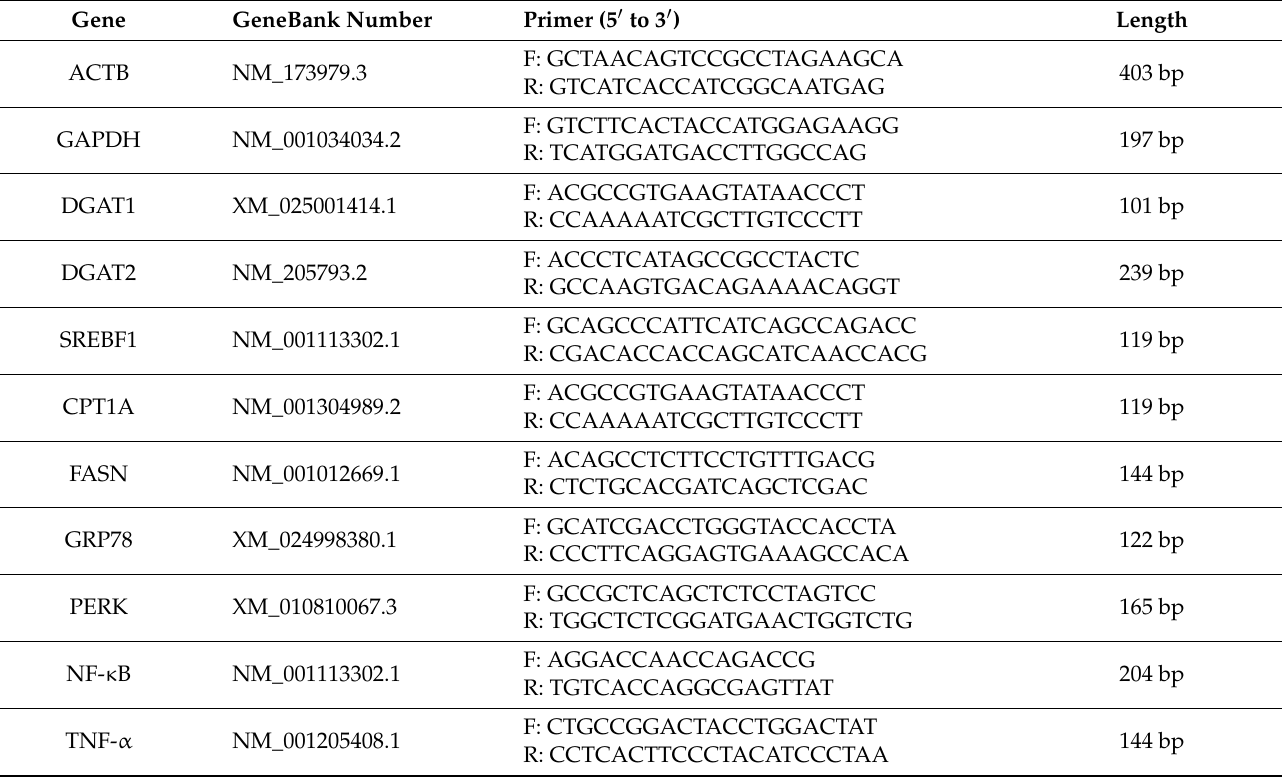
Table 1. Sequences of primers used for real-time PCR